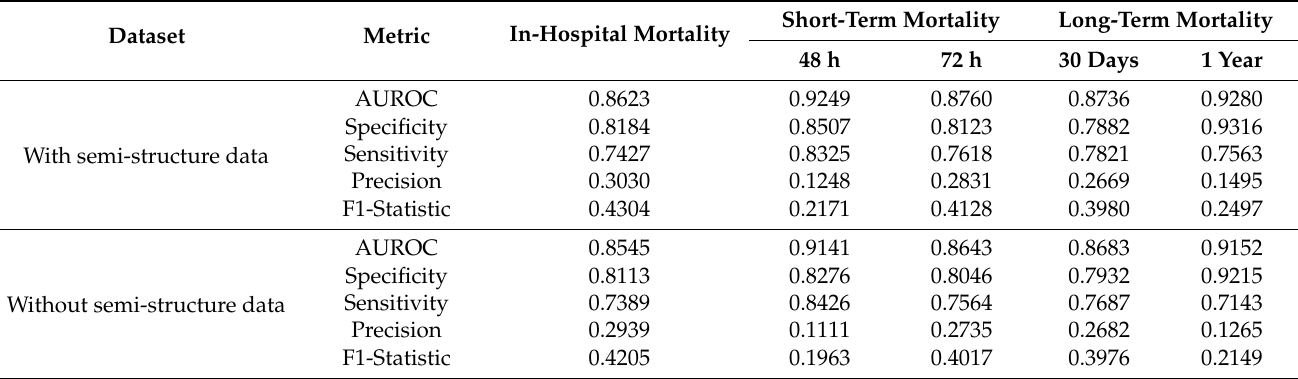
Table 9. Comparisons (made using the GB method) of the prediction results generated by models based on 24 h